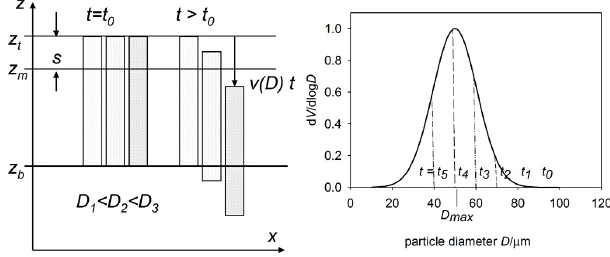
Fig. 19. Schematic explaining the formation of volume size spectra with sudden cut-off near the largest measured diameter D . The left panel shows a horizontal ash layer at two times, t 0 and t > t 0 . The levels of plume top ( z t ) , plume bottom ( z b ) , and level of measure- ment ( z m ) , are identified, with vertical separation s = z t − z m . The three rectangles show plume segments with different particle sizes – separated in x-direction for illustration. For t >t 0 the segment with largest particles has been sedimented uniformly over the largest dis- tance v(D)t . The right panel shows the volume size distribution starting from an arbitrary initial distribution with maximum volume diameter D max at t = t 0 . Because of sedimentation, a cut-off forms and gradually ( t = t 1 ,t 2 , etc.) moves to smaller diameters, so that after time t 4 a volume distribution with maximum at this cut-off evolves.